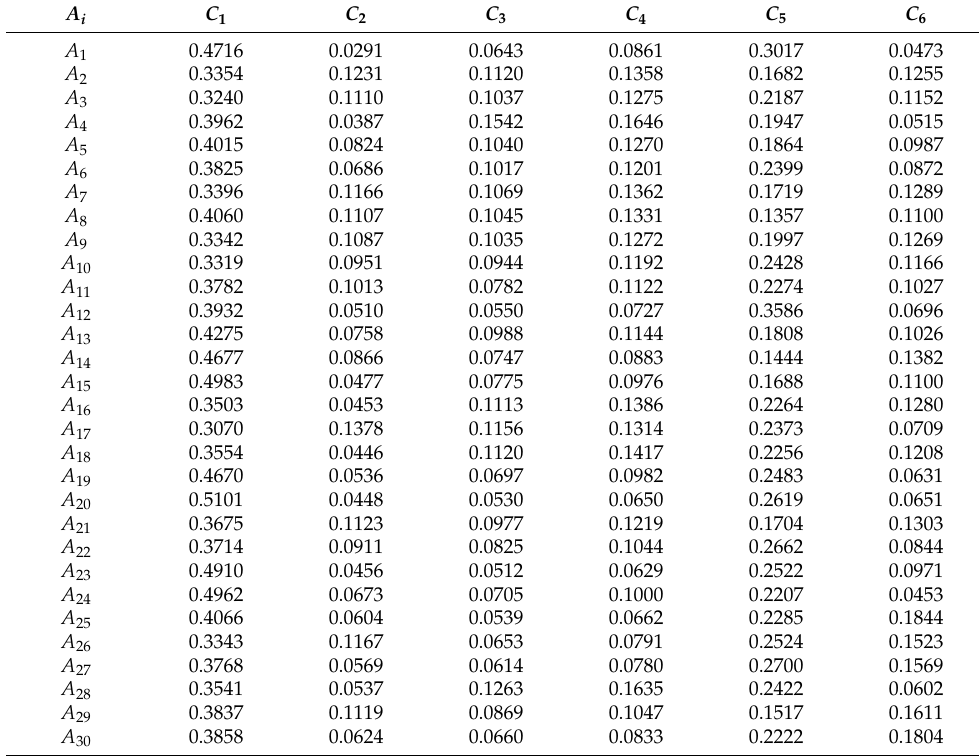
Table 6. Local weights for